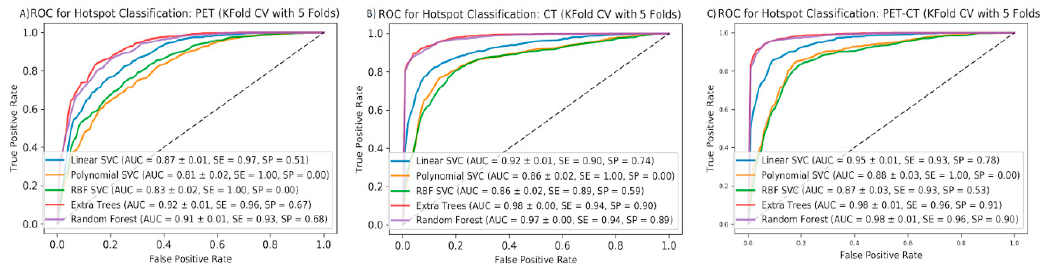
Figure 2. Mean ROC curves for five ML algorithms using five-fold cross-validation to predict pathological vs. non-pathological hotspots using PET ( A ), CT ( B ), and all features ( C ). AUCs (STDs), sensitivities, and specificities are shown for each ML method applied to each feature group.